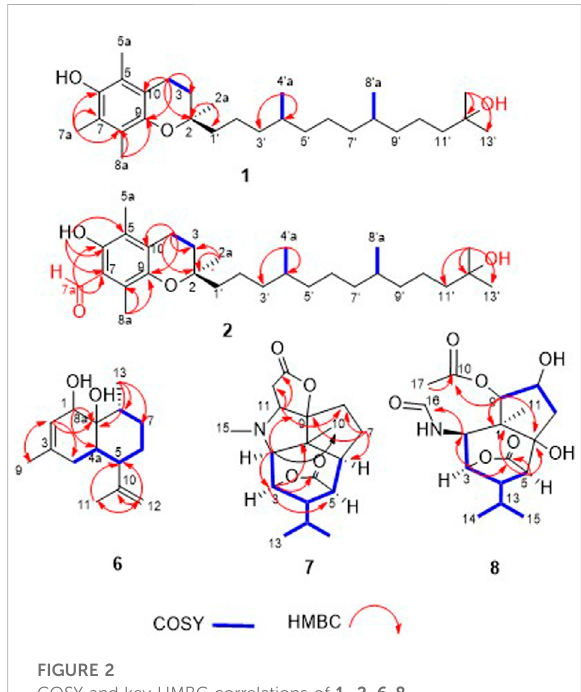
FIGURE 2 COSY and key HMBC correlations of 1 – 2 , 6-8